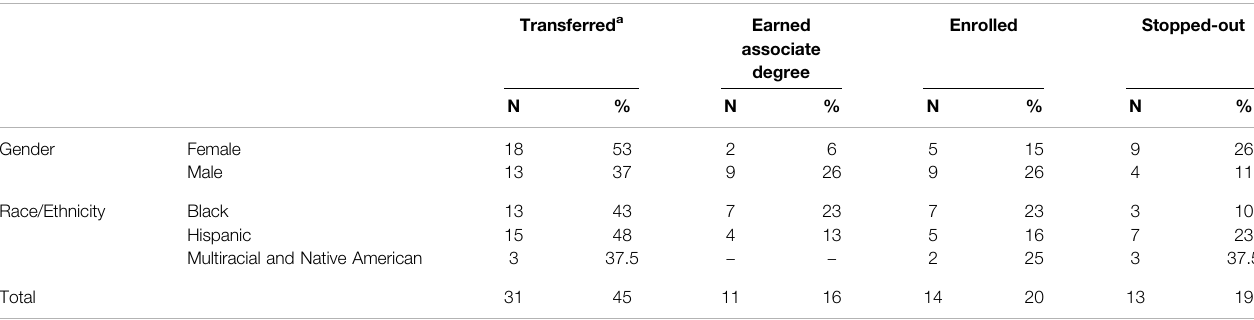
TABLE 5 | Transfer pathway progress by gender and race/ethnicity for ISP participants ( N (cid:1)